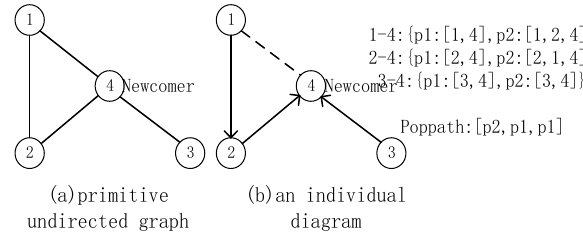
11 of 22 Algorithm 1 Providers node selection based on bandwidth sorting between node sets Input: N n node-set and N p node-set. Output: provider nodes. 1: